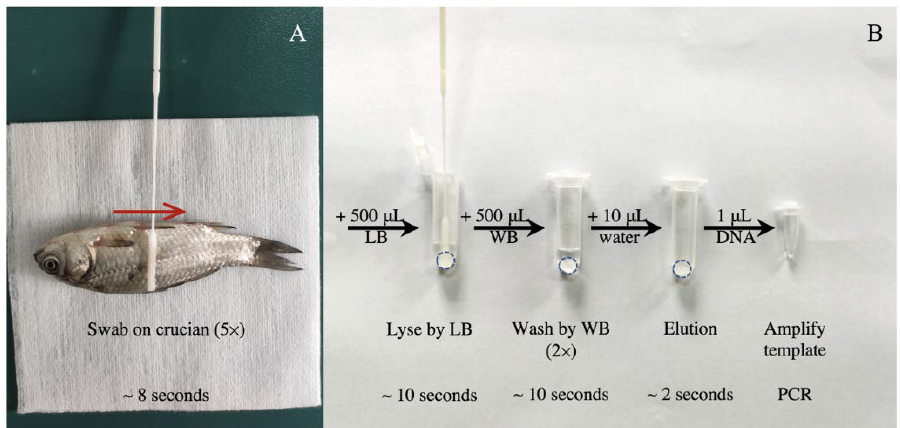
Figure 1. Overview of 30 s skin swabbing and disc method. ( A ) Mucus collection from a scaled fish; red arrow indicates the direction of swabbing. The process is repeated five times for about 8 s in total. ( B ) DNA is purified from the mucus. The swab with mucus is immediately dipped into a 1.5 mL Ep tube with 500 μL lysis buffer (LB) and a disc (dotted circle) for 10 s. Then, 500 μL wash buffer (WB) is transferred into the tube and incubated for 5 s two times. Last, 10 μL ddH 2 O is added into the tube to dissolve DNA captured by the disc, and the 1 μL template is transferred to the PCR reaction mix.